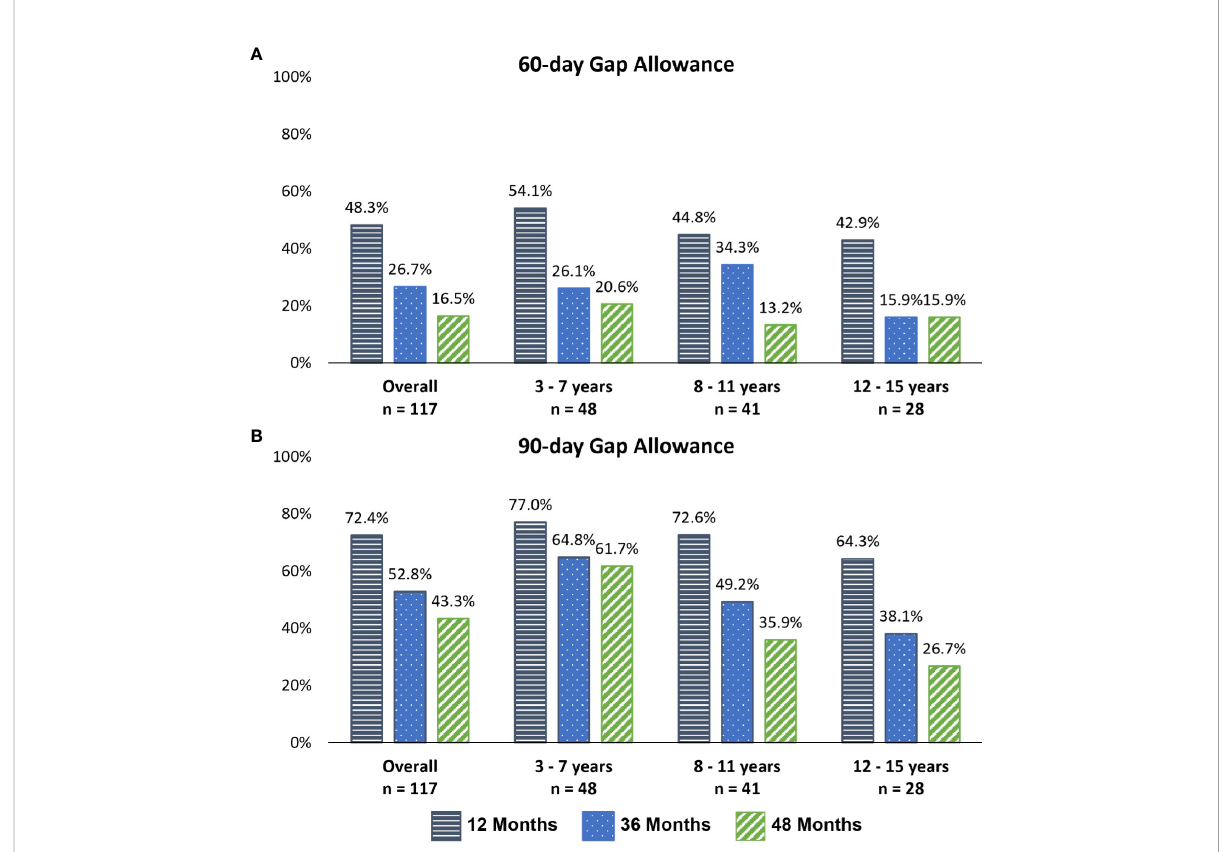
FIGURE 2 Persistence with somatropin throughout follow-up, by age group and follow-up cohort. (A) A 60-day gap de fi nition of discontinuation. (B) A 90-day gap de fi nition of